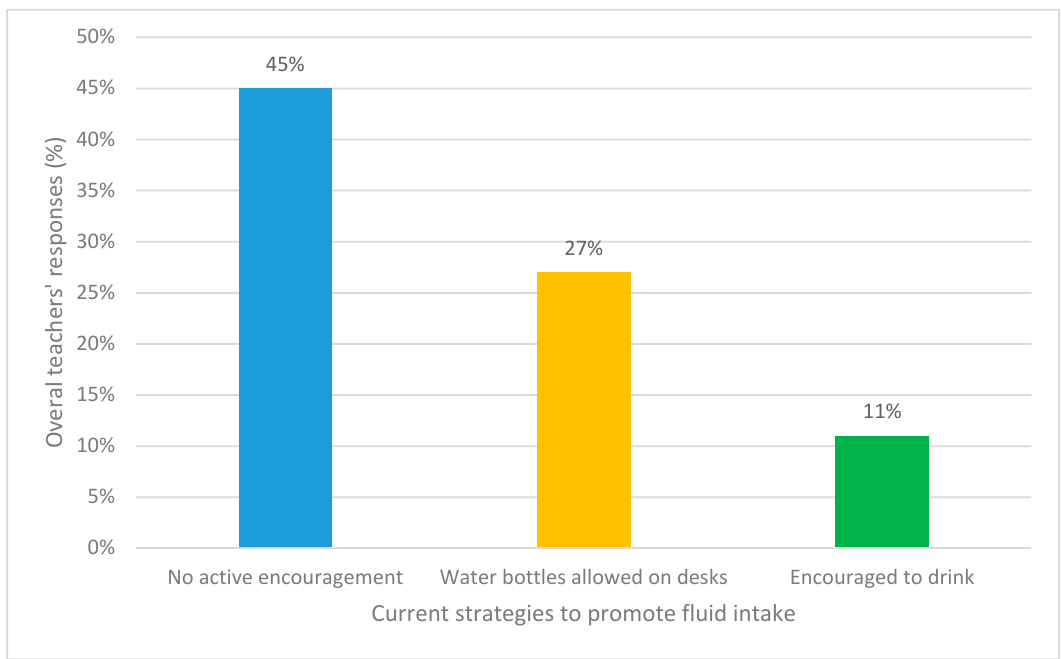
Figure 3. Teachers’ most popular responses for how their schools currently promote fluid consumption.